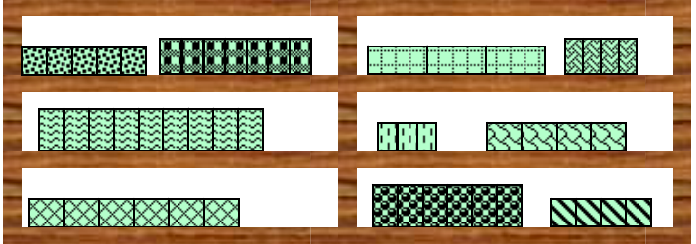
Figure 1. An example of a planogram.